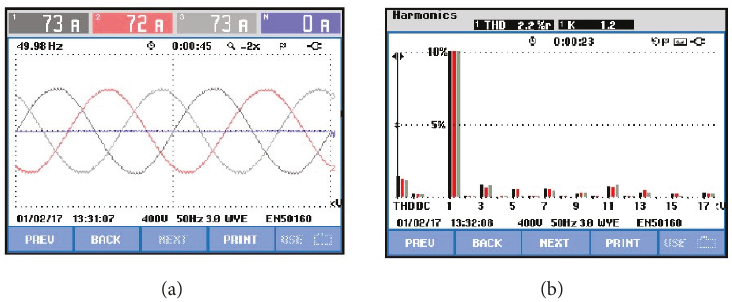
Figure 21: The experimental waveforms and THD of grid currents using the proposed method ( 𝑘